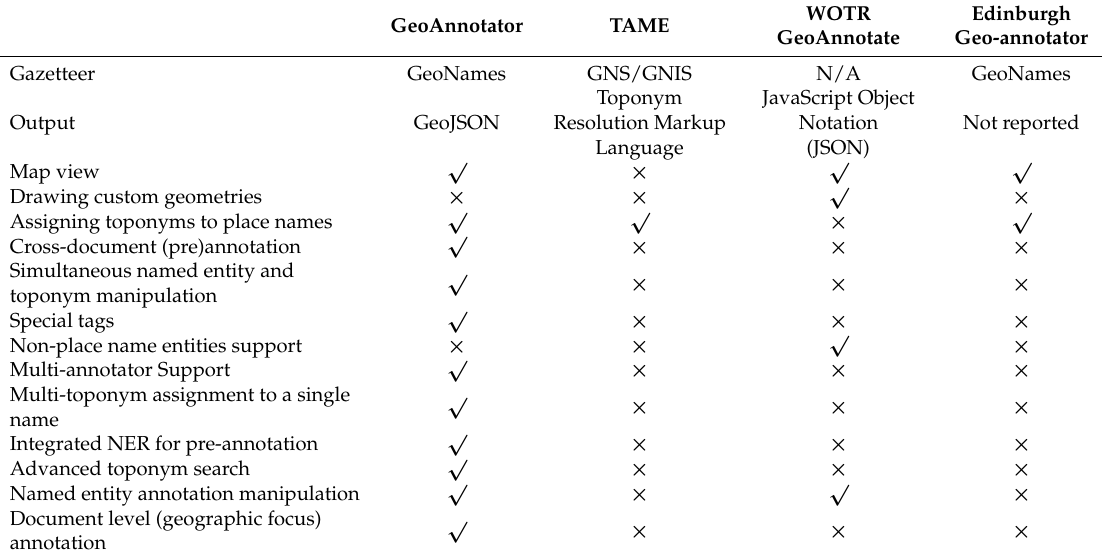
Table 6. A comparison of the features of geo-annotation